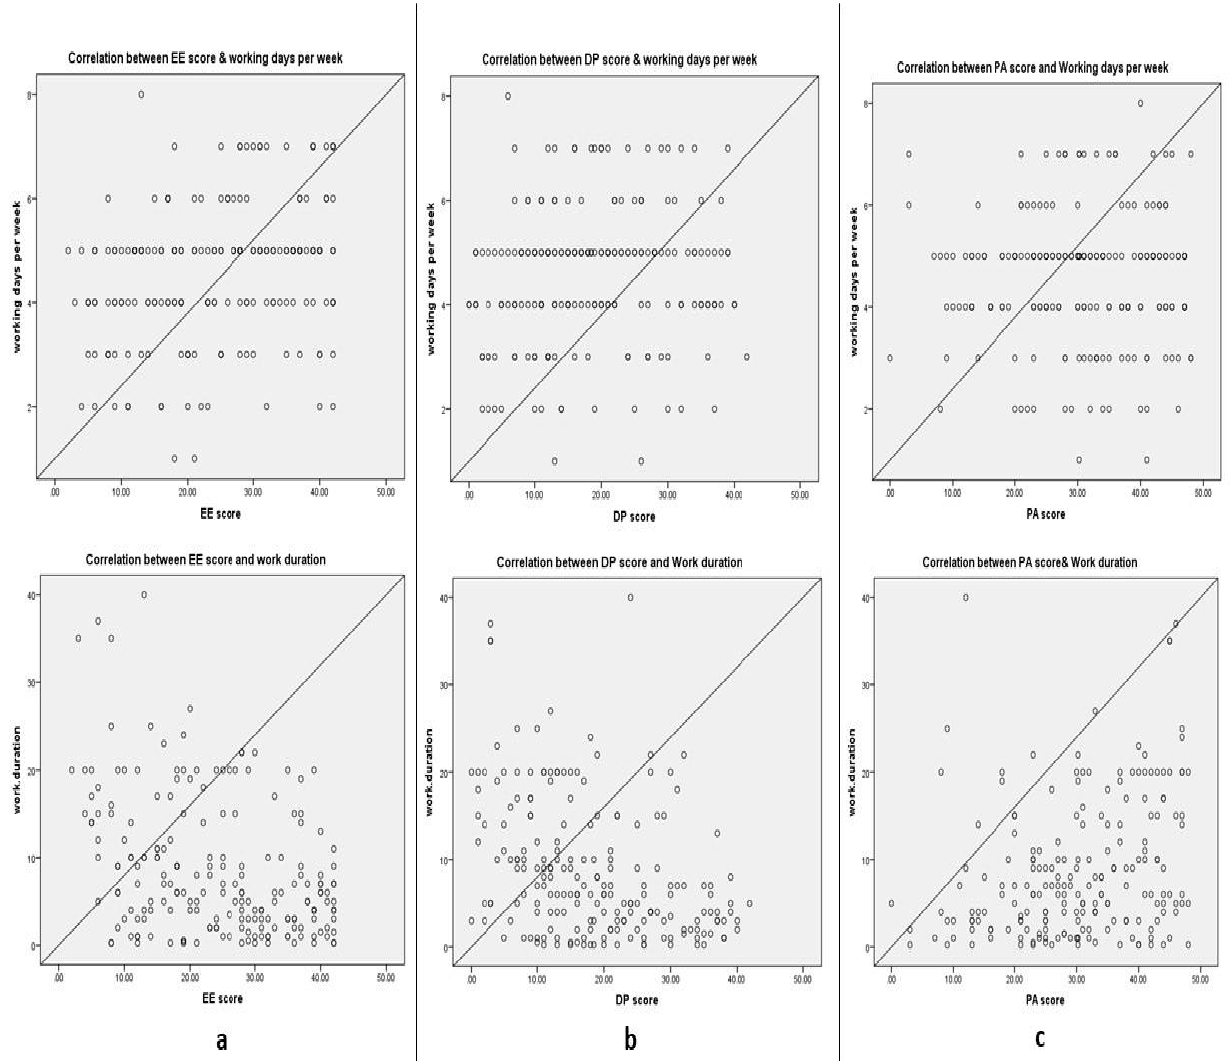
Figure 2. Correlation between working duration and working days per week of physicians and their EE score ( a ), DP score ( b ), and PA score ( c ).